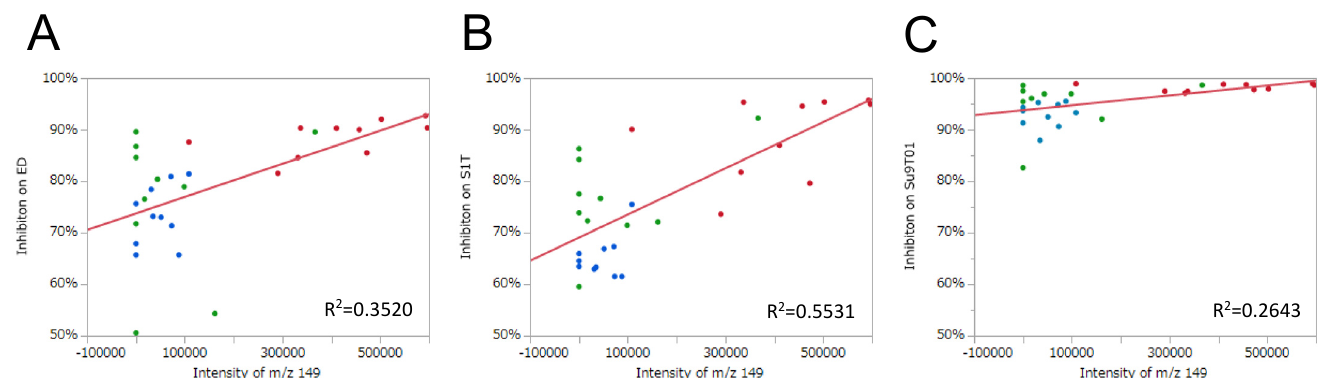
Figure 3. The bivariate analysis of ATL cell proliferation inhibitory activity and peak intensity at m/z 149 on DI-EI-MS analysis. The m/z 149 peak was extracted as having the highest R 2 value in the measurement range m/z 50–500, and the results were common to all three ATL cell lines. ( A ) ED cells, ( B ) S1T cells, and ( C ) Su9T01 cells. Green circles indicate leaves, red circles indicate stems, and blue circles indicate leaf/stem mixtures.